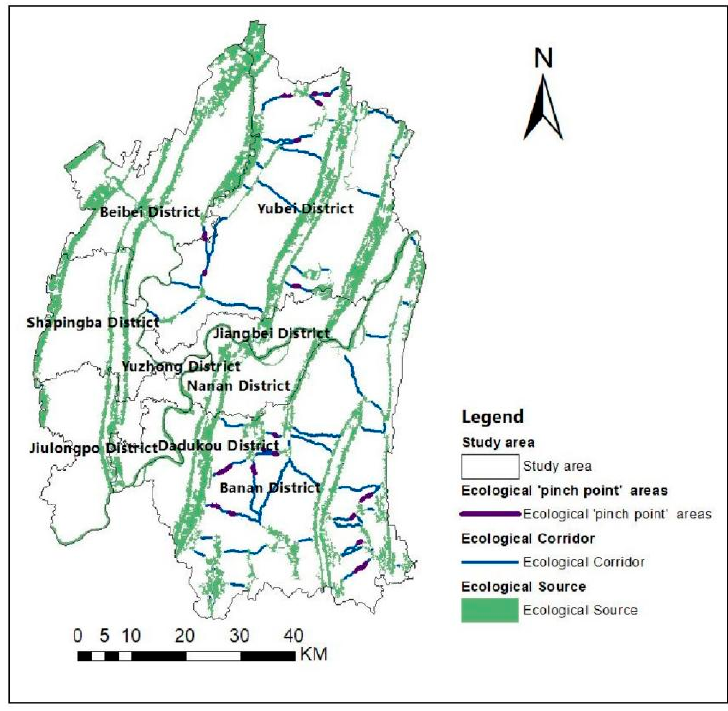
Figure 11. Ecological “pinch point” distribution.